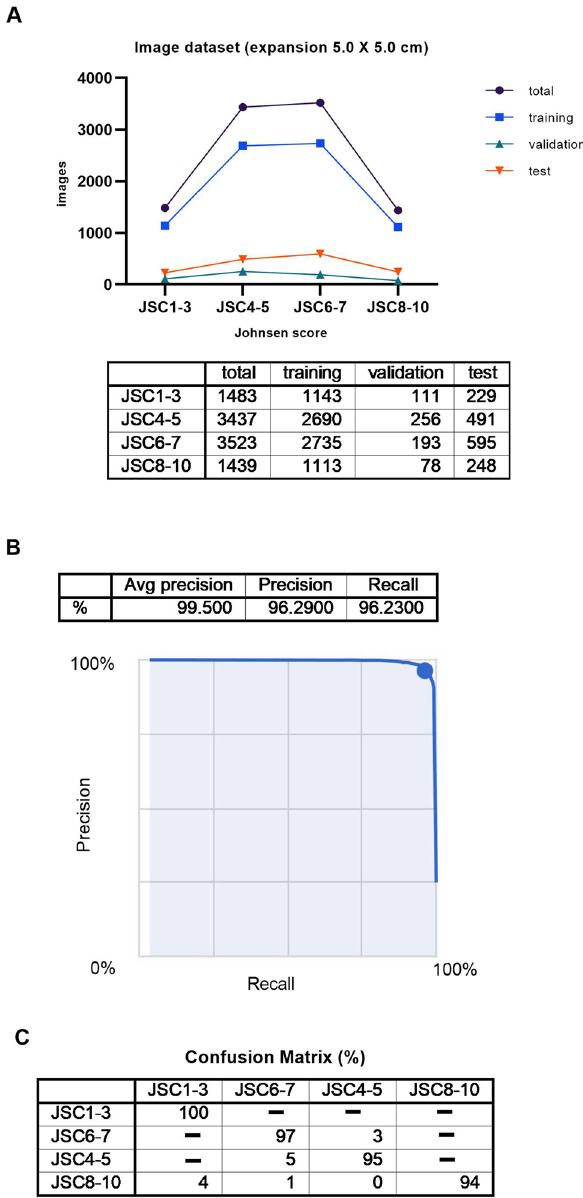
matrix for image dataset, expansion, 5.0 × 5.0